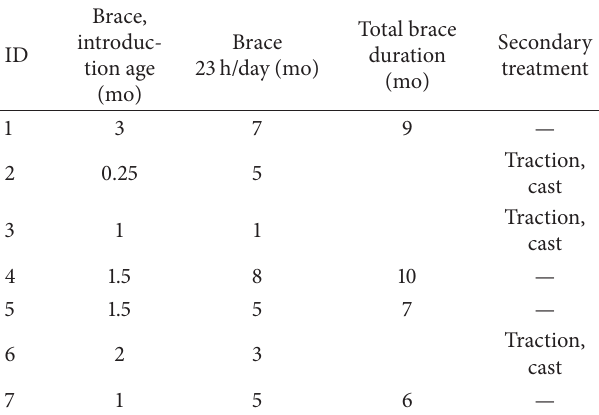
Table 5: Brace duration, unilateral dysplasia. Table 6: Brace duration, bilateral